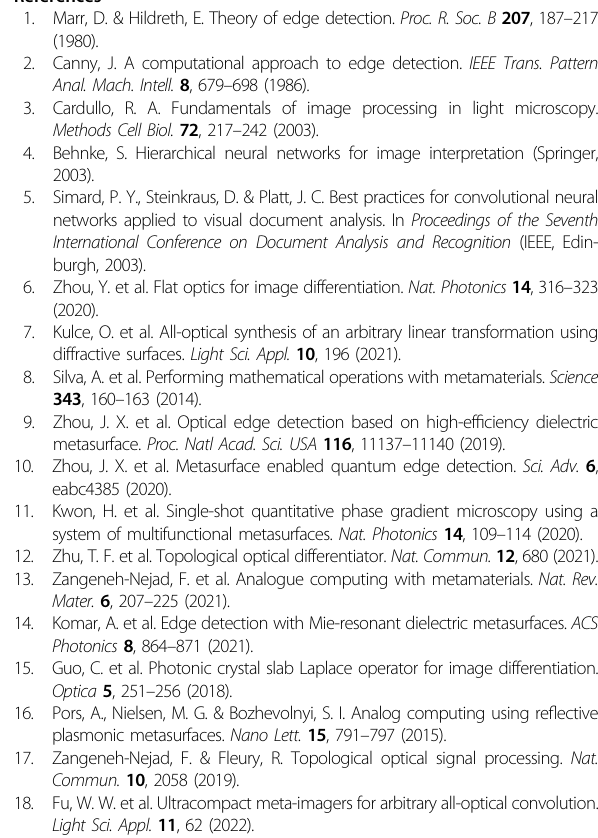
controls both the phase and amplitude of light as shown in Fig. 1, opening up new possibilities for metasurface-based CNN processors 18 . Any imaging system can be described as a convolution operation between the optical fi eld of an object and the point spread function (PSF) of the optical elements